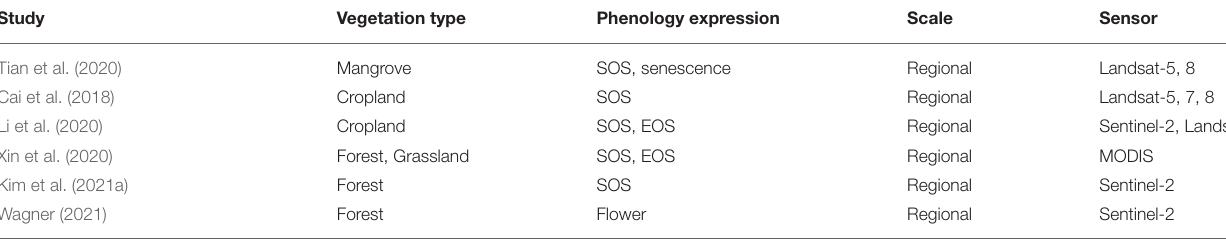
TABLE 4 | Overview of studies that used satellite imagery for phenological study with DL